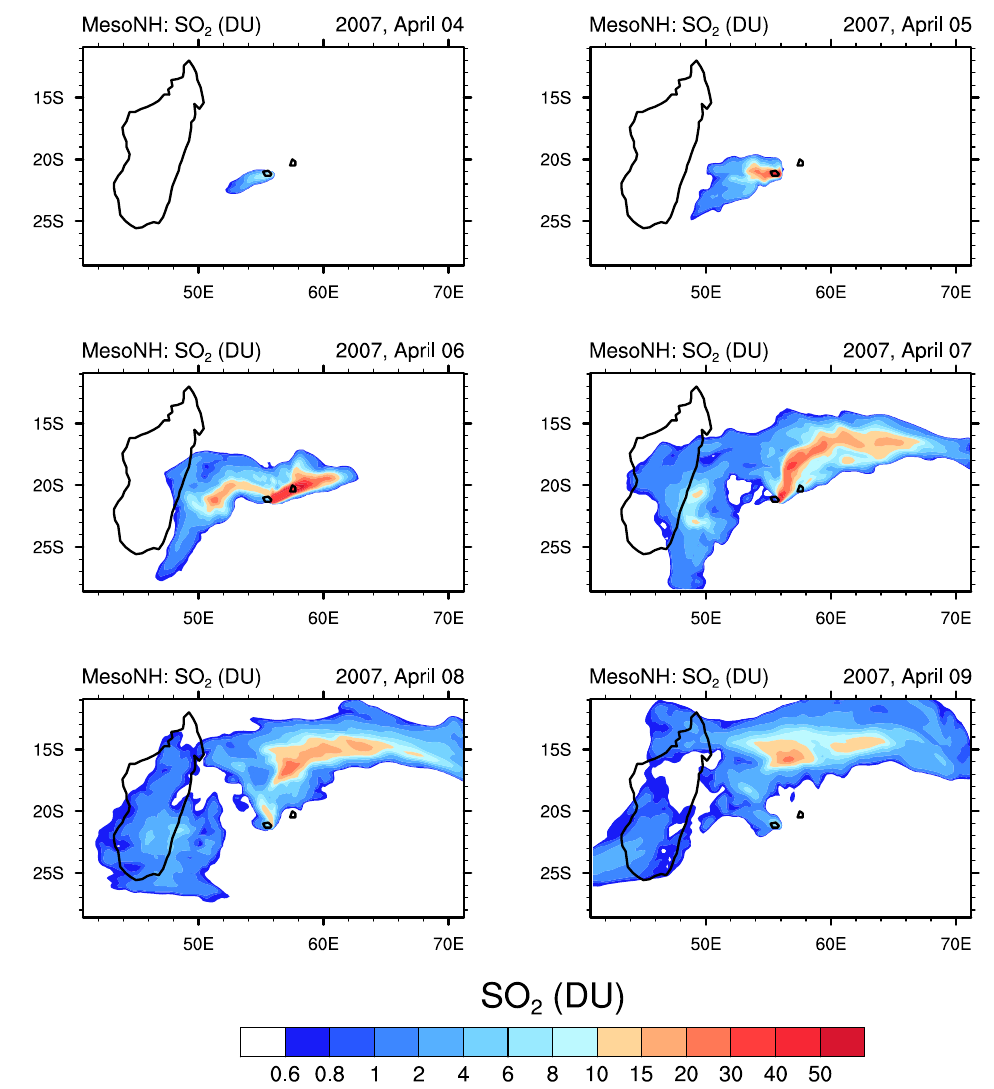
Fig. 5. Evolution of SO 2 mass burden simulated by MesoNH at 12 UTC for the period April 4-9, 2007.